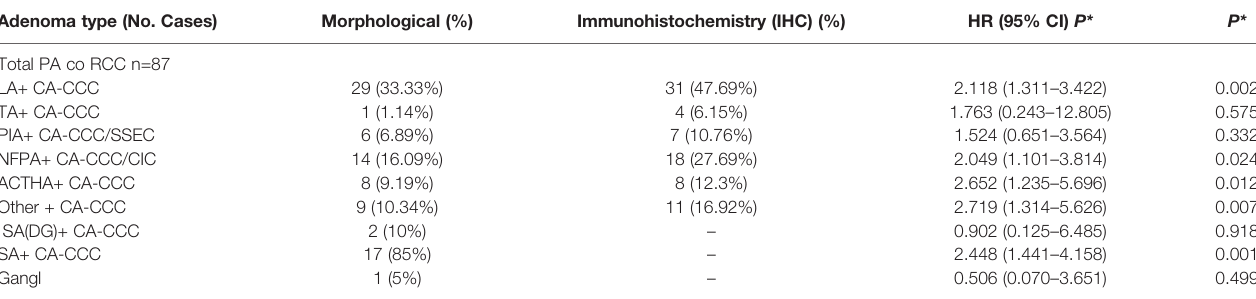
TABLE 2 | RCC coexistent pituitary adenoma subtype and histopathological features and immunohistochemistry. Adenoma type (No. Cases)